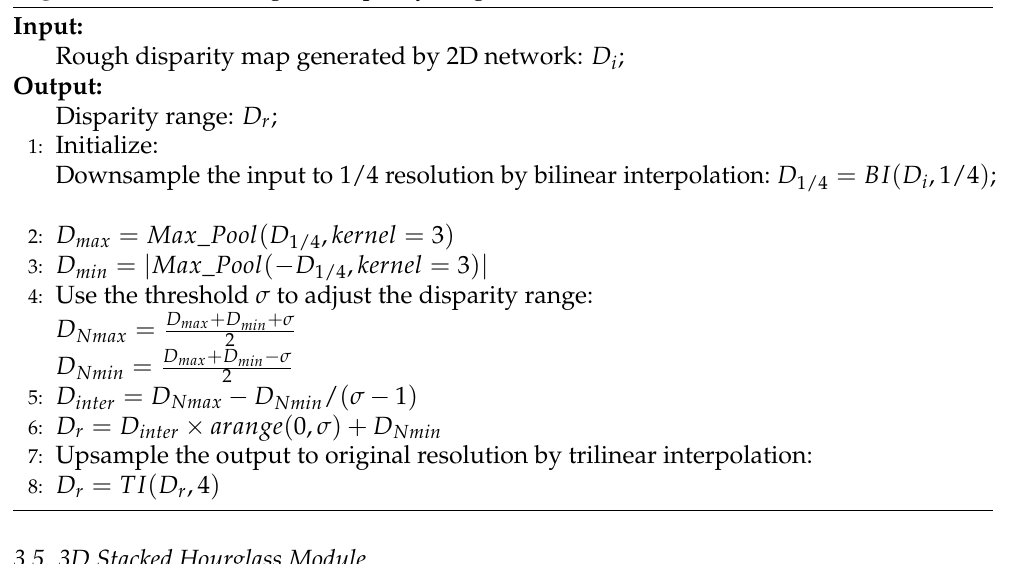
Algorithm 1 Calculating the disparity